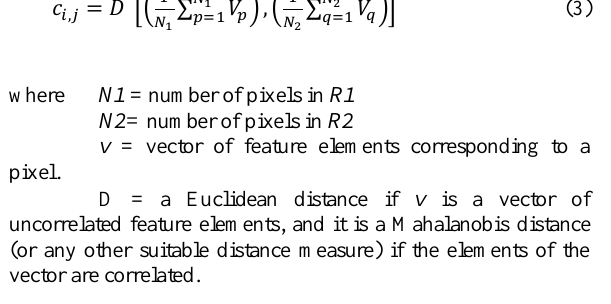
Figure 1. Work Flow diagram of SS7KD Saliency Model